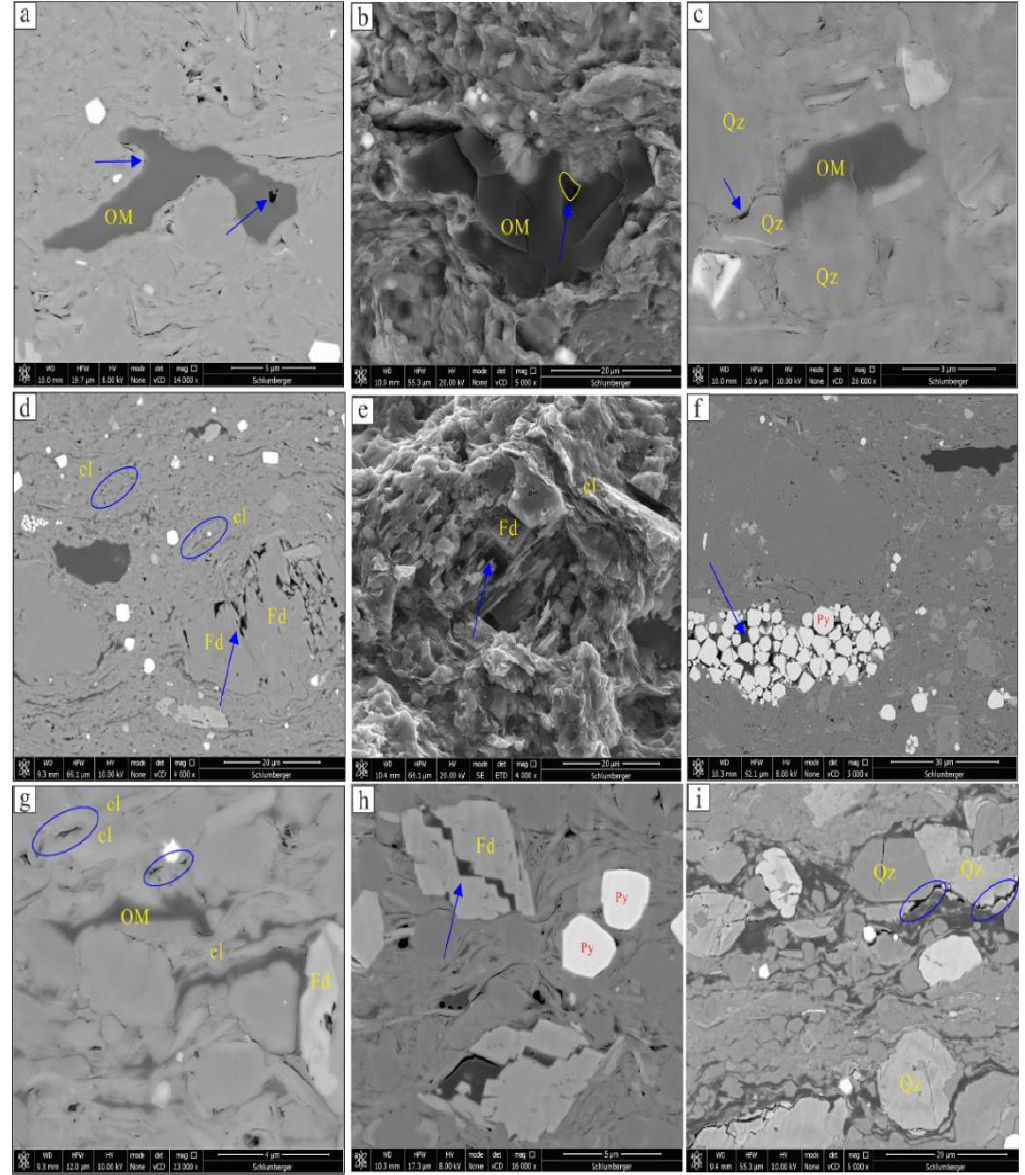
Figure 4. Types of reservoir space in K 2 qn 1 Member of Da’an area, southern Songliao Basin ( a ) 2044.95 m, pores inside organic matter particle, (marked by blue arrows); ( b ) 2044.95 m, pores at the edge of organic matter, (marked by blue arrows) SEM;( c ) 2050 m, intergranular pores,(marked by blue arrows);( d ) 2041 m, pores inside clay particles(marked by blue circles), dissolution pores inside feldspar particles(marked by blue arrows);( e ) 2041 m, dissolution pores inside feldspar particles(marked by blue arrows);( f ) 1981 m, intercrystalline pores in pyrite(marked by blue arrows);( g ) 1981m, intercrystalline pores between clay particles(marked by blue circles);( h ) 1981 m, fissures formed by compaction(marked by blue arrows);( i ) 1999 m, tectonic micro-fissures(marked by blue arrows). OM: Organic matter, Qz: Quartz, cl: Clay, Fd: Feldspar, Py: Pyrite.